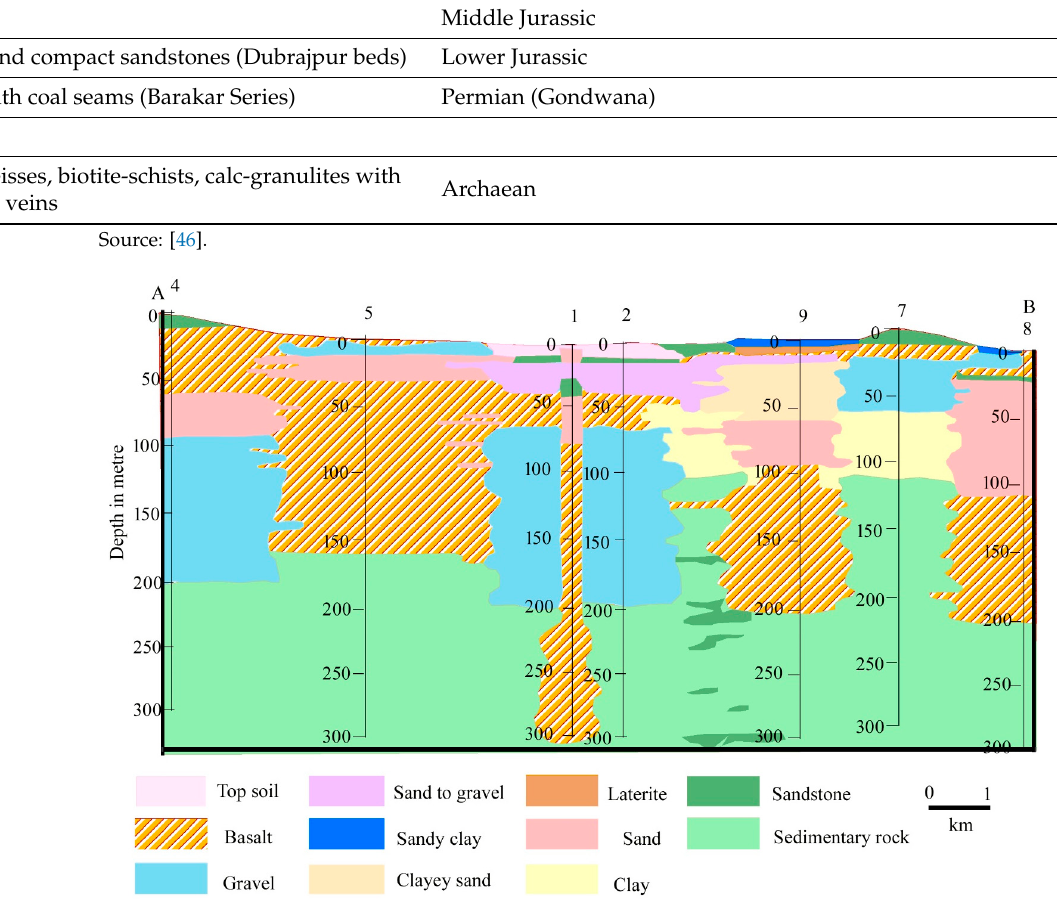
Table 7. Stratigraphic sequence in the Birbhum area.